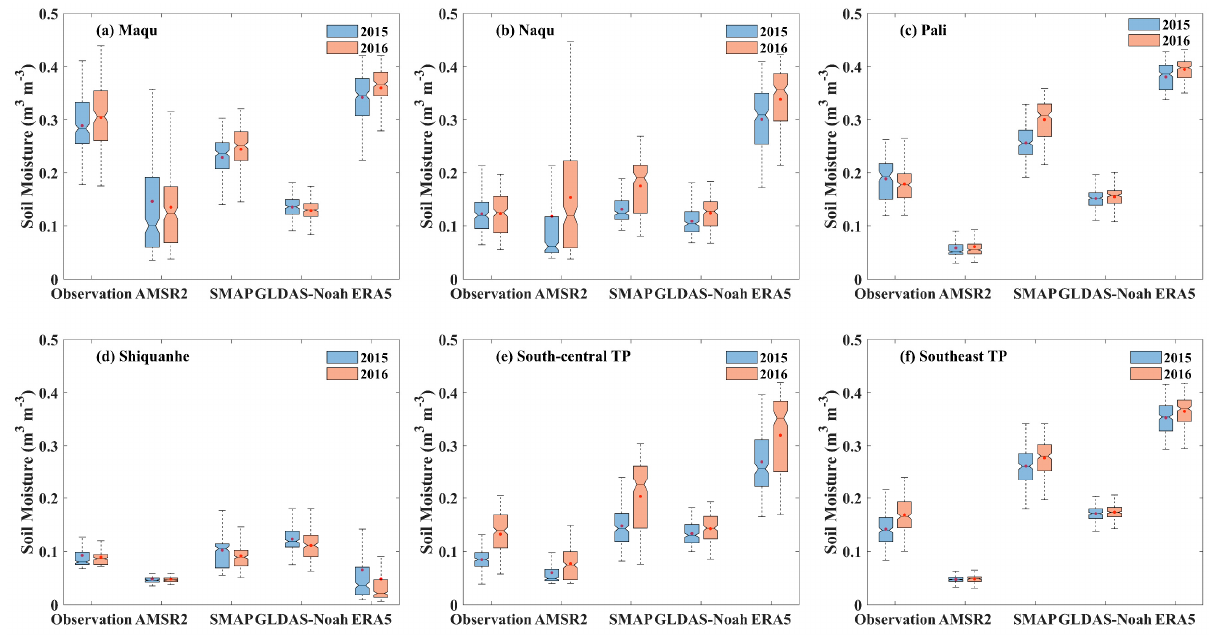
Figure 3. The boxplots for in situ observed, AMSR2, SMAP, GLDAS-Noah, ERA5 SM, and the in situ rainfall observation in April–October in 2015 and 2016 in different TP regions. The red dots represent the averaged values. For clarity, the outliers are omitted in the boxplots.